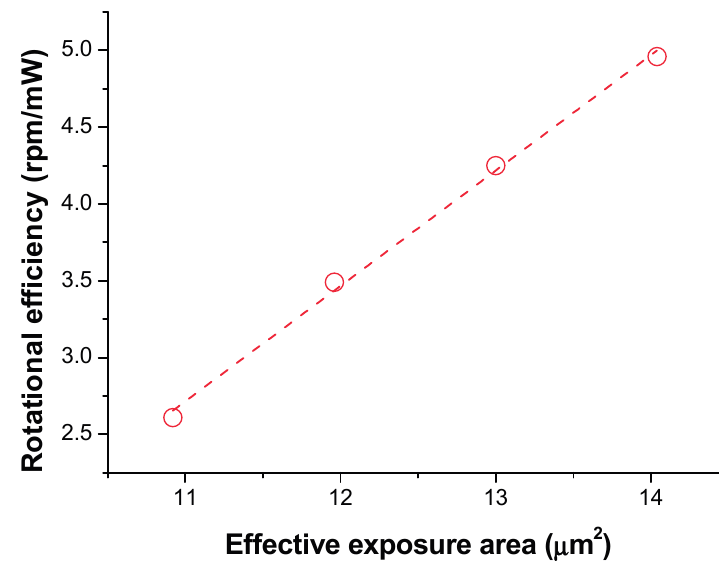
Figure 11. Rotational efficiency versus effective exposure area.